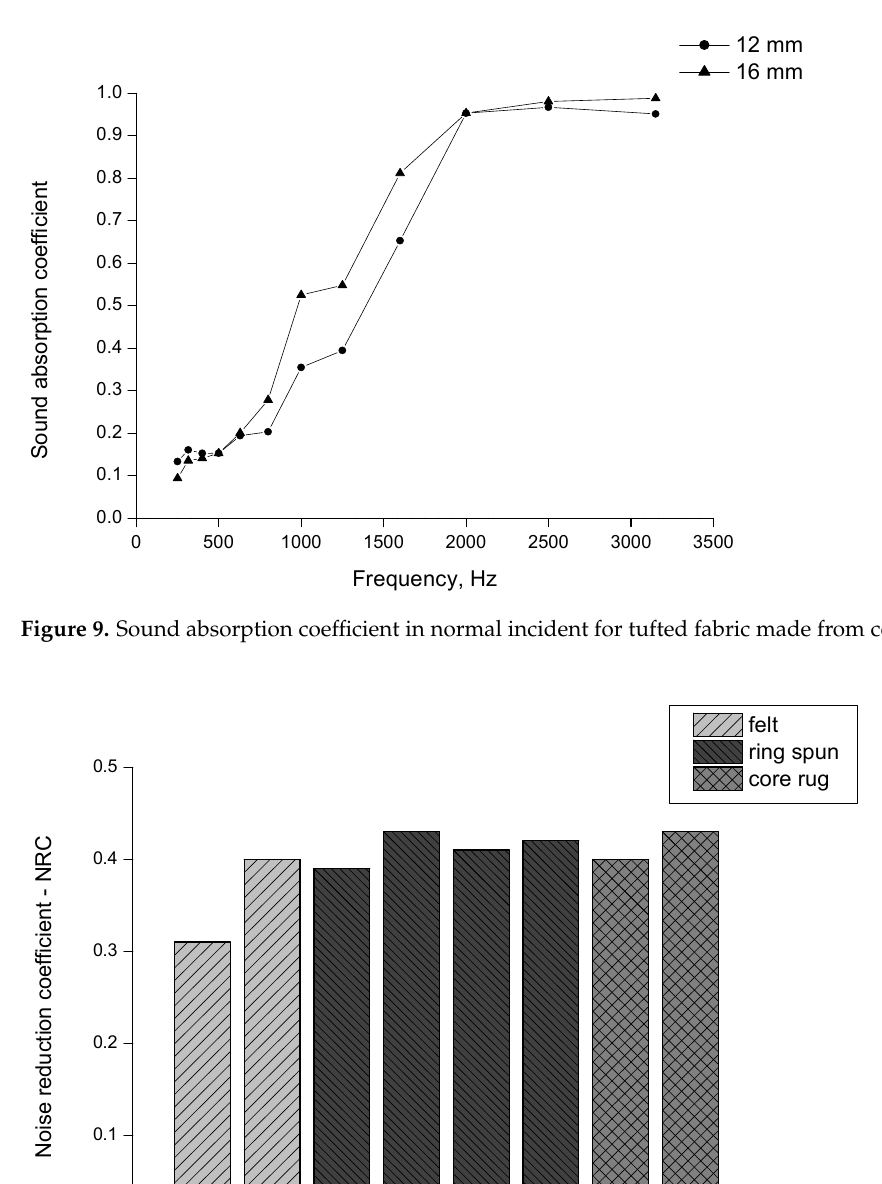
the tufted fabrics made both of the ring spun and the core rug yarns, the NRC value was between 0.4 and 0.43. For both types of yarn, the greater the pile height, the slightly higher the NRC value.